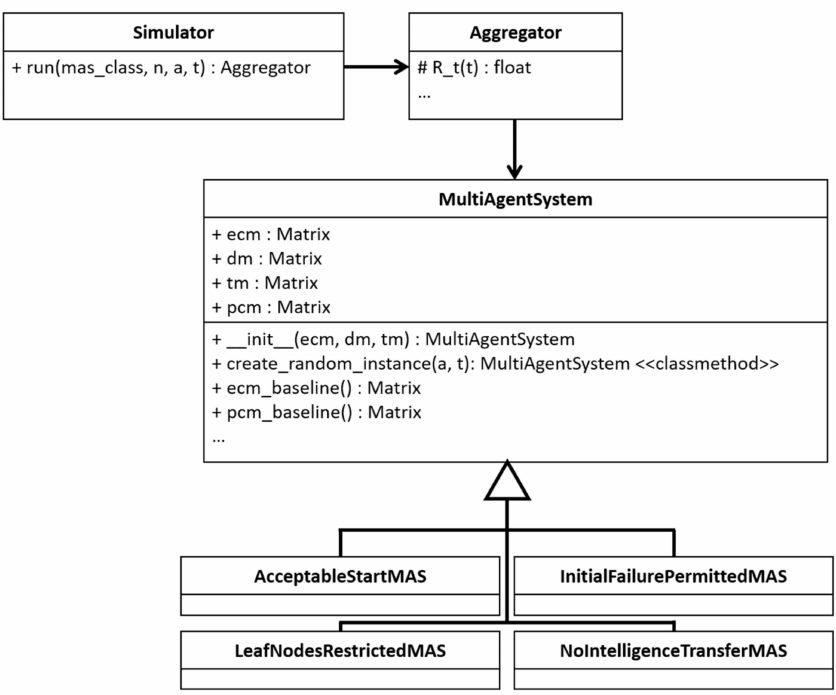
Figure 29. High-level system architecture of the Large-Scale Simulation Environment